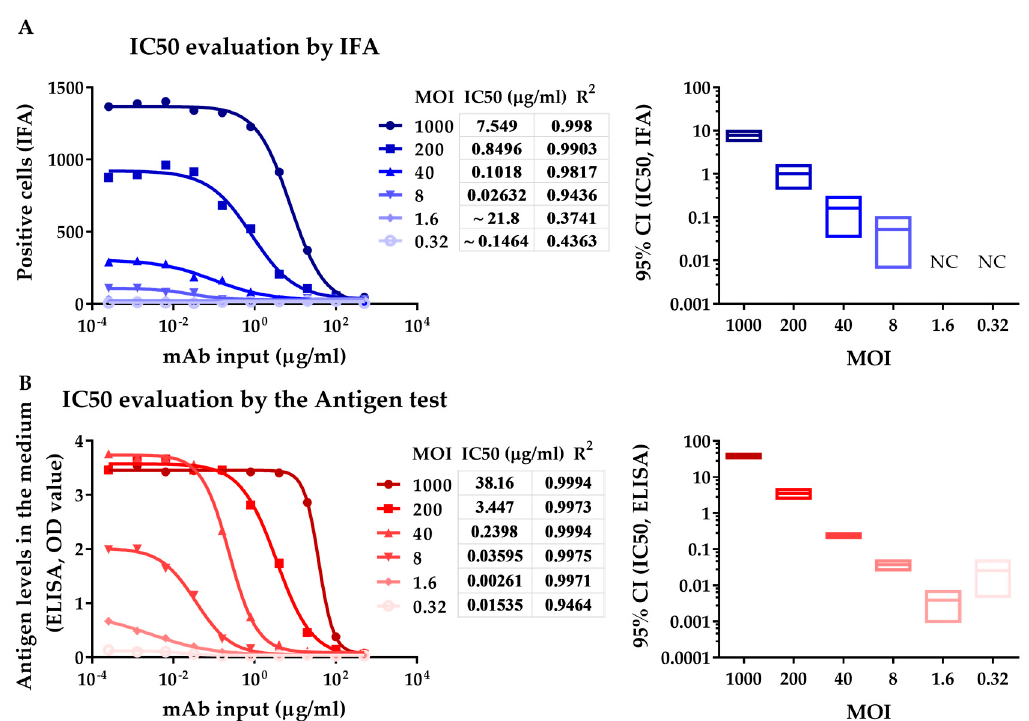
Figure 2. Comparison of the IFA and enzyme-linked immunosorbent assay (ELISA) methods by measuring the neutralizing capacity of the HEV-specific mAb 12F12. ( A ) IC50 evaluation by IFA shows the number of positive cells 8 days after inoculation with mixtures of dilutions of 12F12 and HEV (0.32 to 1000 MOI) (left panel). ( B ) IC50 evaluation by neutralizing assay involving antigen ELISA test shows the antigen in medium 8 days after inoculated with mixtures of dilutions of 12F12 and HEV (0.32 to 1000 MOI) (left panel). The left panel curves were fitted for nonlinear regression (log [inhibitor] vs. response, variable slope). The right panels display 95% confidence intervals of IC50 at various MOIs detected by IFA and ELISA. NC, not calculated.